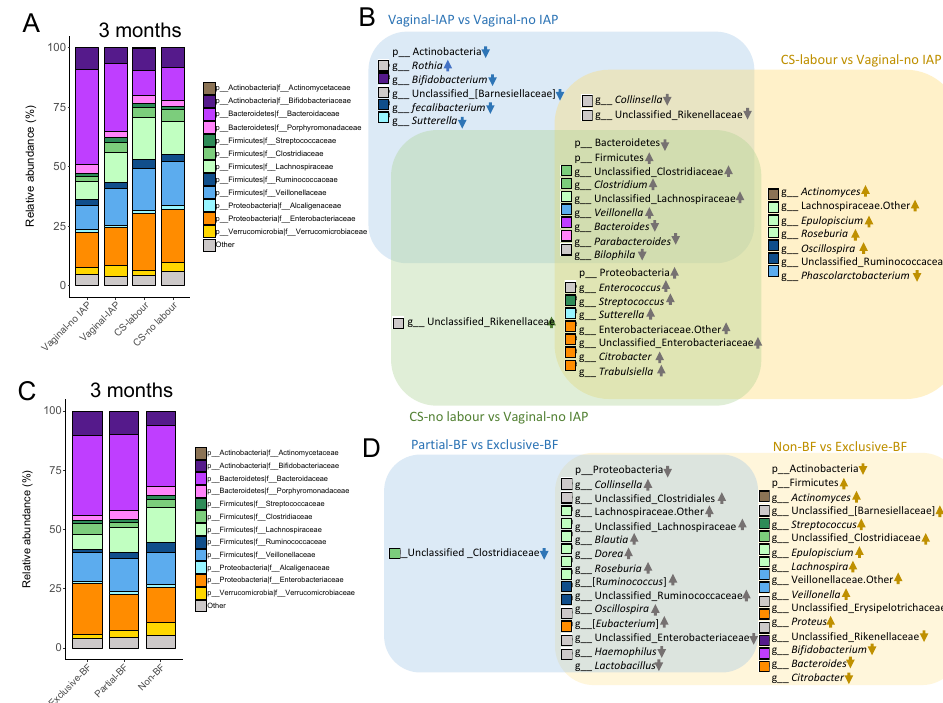
Figure 2. Specific microbial taxa in the infant gut are associated with birth events and breastfeeding exclusivity at 3 months. ( A , C ), average gut microbial taxa at family level of infants, showing the bacterial families with average relative abundance > 1%. ( B , D ), the discriminative taxonomic biomarkers of infant gut microbial taxa at phylum and genus level were identified using LEfSe. Significant differences were determined by an LDA score > 2 and p -value < 0.05. Upwards arrows indicate higher abundance, whereas downwards arrows indicate lower abundance of microbial taxa than reference groups (vaginal-no IAP and exclusive-BF for birth events and breastfeeding exclusivity, respectively). Arrows for shared taxa in overlapping area were in grey and arrows for unique taxa were in specific colors. Bacterial genera ( B , D ) and their corresponding family ( A , C ) share the same colors of square.